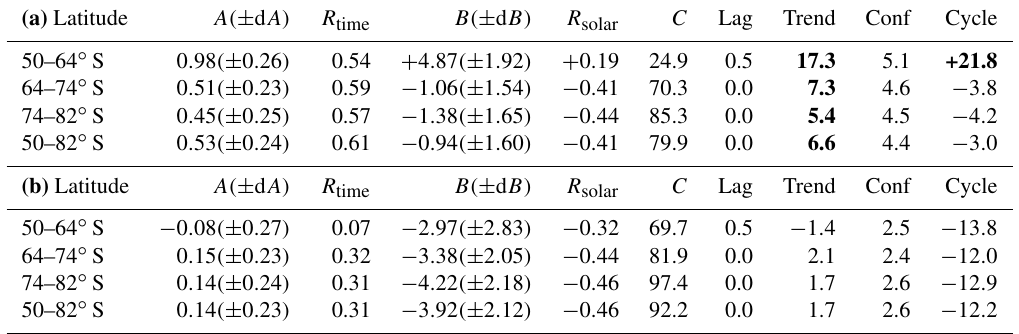
Table 3. (a) Regression fit results for IWC, Southern Hemisphere, 1979–1997. (b) Regression fit results for IWC, Southern Hemisphere,